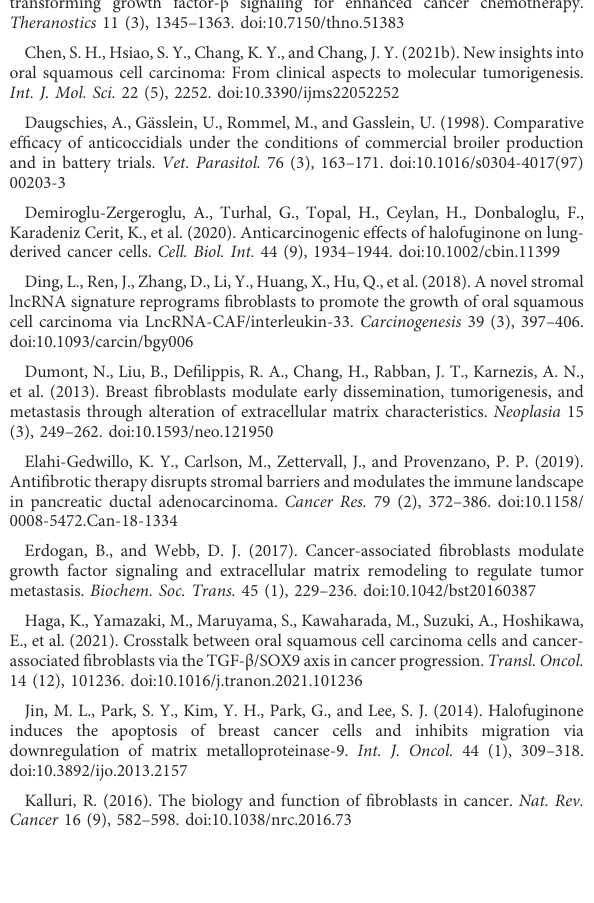
SUPPLEMENTARY FIGURE S1 EffectsofHF-treatedCAFsontheproliferation,migration,andinvasionof HSC3 cells. (A) CM had no effect on the proliferation of HSC3 cells. (B) CM treated with high-concentration (100 nM) HF could signi fi cantly inhibitthemigrationofHSC3cells(100×).Transwellexperimentsshowed that HF-treated CAFs signi fi cantly inhibit tumor migration (C) and invasion (D) . *: p < 0.05, **: p < 0.01, ***: p <